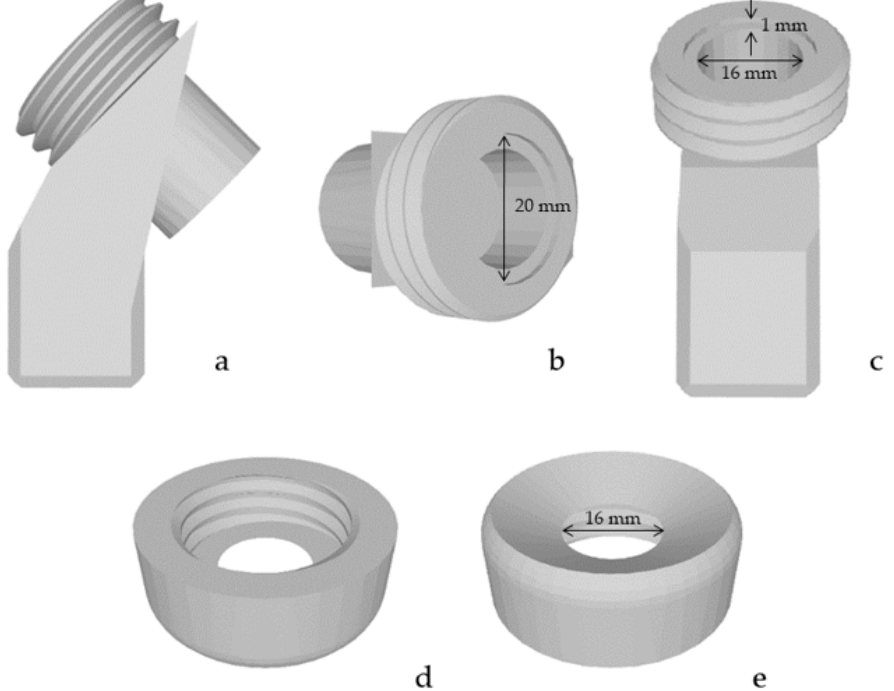
Figure 2. Setup attachment for tests at an angle of 45° without prestress. The base of the attachment with the cubic adapter viewed from the side ( a ), from the top ( b ) and the front ( c ). The lid of the attachment viewed angled from the bottom ( d ) and angled from the top ( e ).